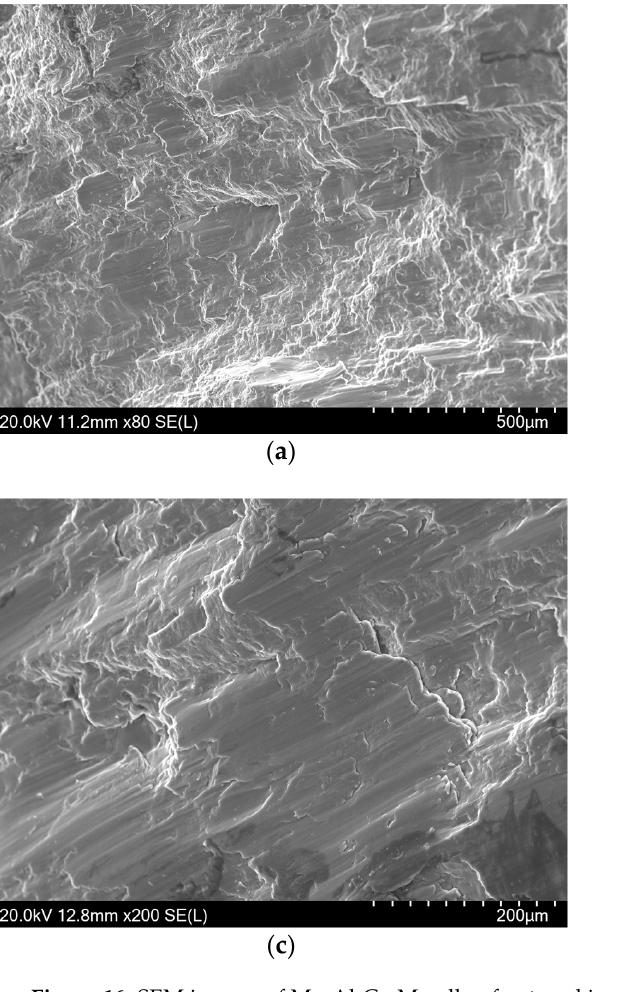
Figure 16. SEM images of Mg-Al-Ca-Mn alloy fractured in vertical 45° direction that show ( a,b ) the river patterns without big steps and ( c,d ) the smooth planes.